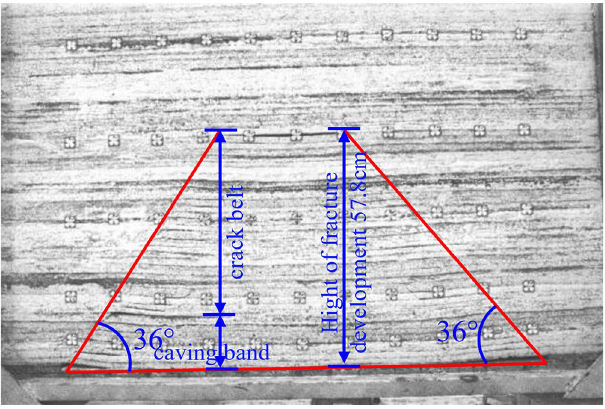
Figure 10. Caving diagram of advancing 160 cm overburden in the working face.